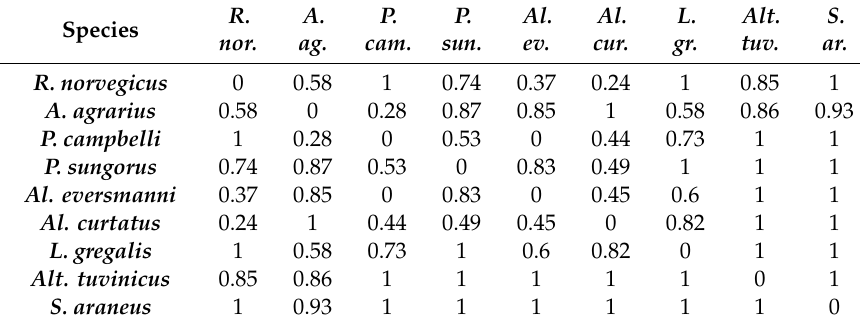
Table 6. Volumes of coe ffi cients of association for the 2 × 2 matrices.